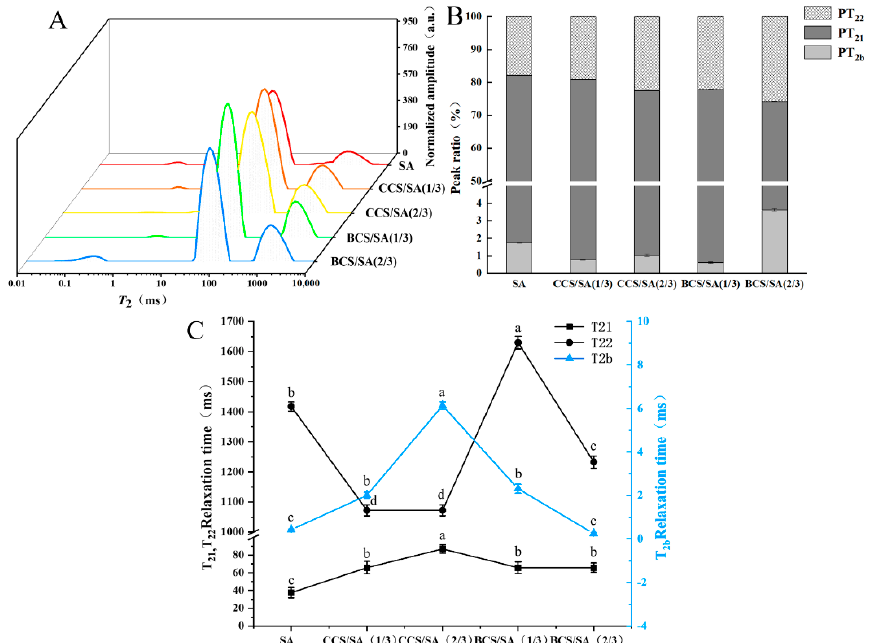
Figure 5. Water distribution in the SA, CCS/SA (1/3), CCS/SA (2/3), BCS/SA (1/3), and BCS/SA (2/3) hydrogels. ( A ) T2 relaxation time distribution. ( B ) Relative composition of water types. ( C ) T2 relaxation time profiles based on the corresponding top peaks. Here, PT2b, PT21, and PT22 are the relative percentages of bound water, immobilized water, and free water, respectively. Different lowercase letters (a–d) indicate significantly different mean values ( p < 0.05).